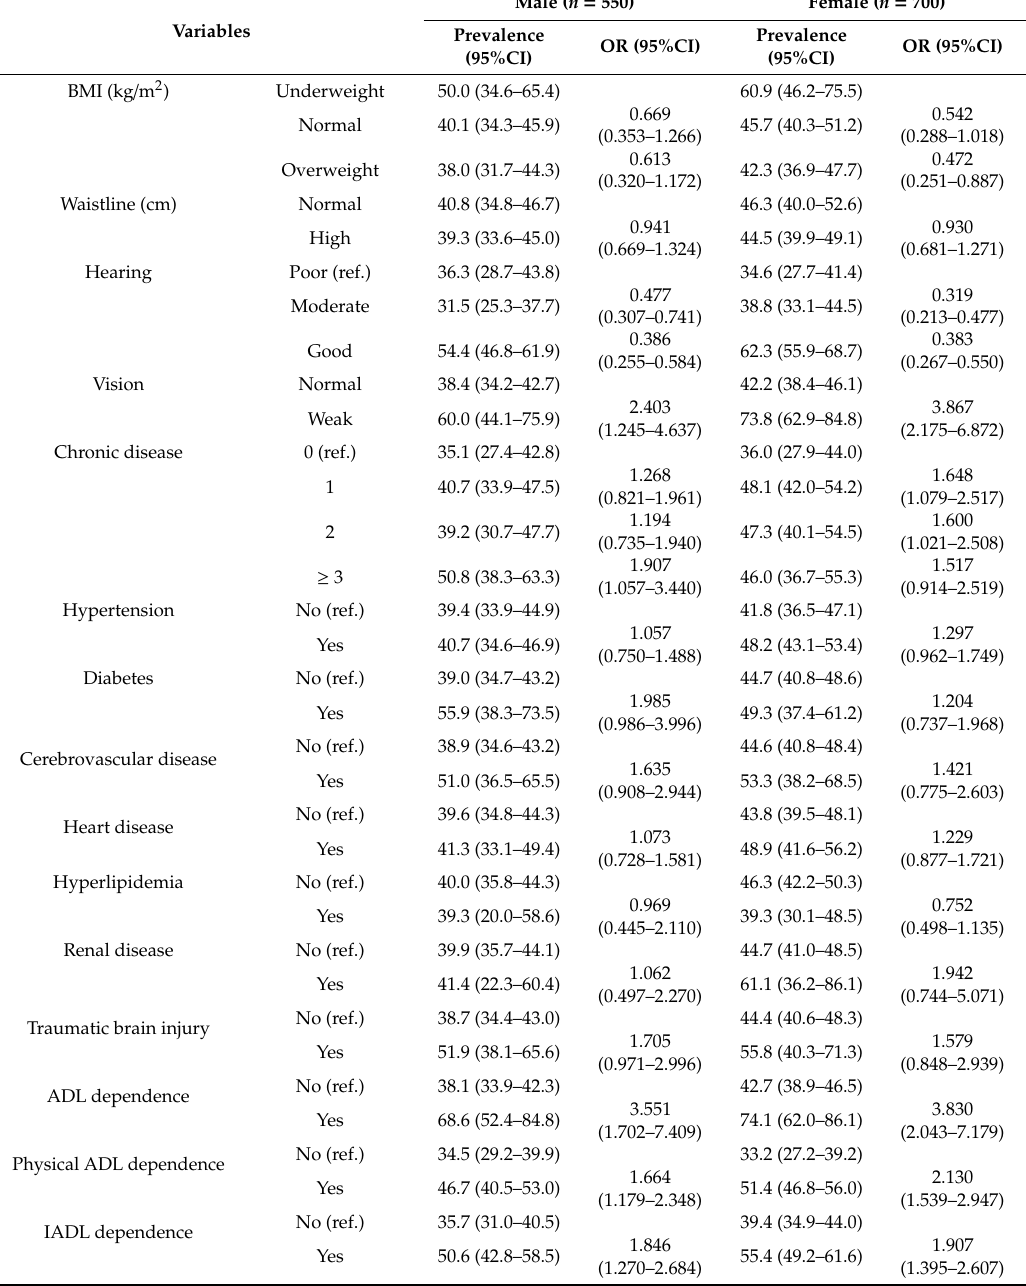
Table 5. Prevalence of cognitive impairment and univariate analysis of health-related